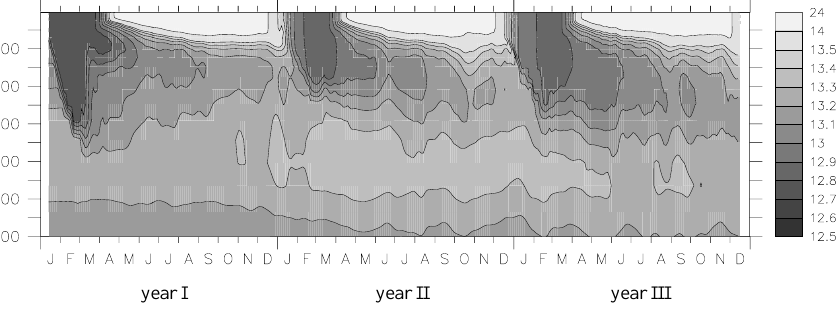
Fig. 14. Temporal evolution of the vertical profile of temperature (shaded, isotherms in ◦ C) in the central Gulf of Lions (5 ◦ E 41.5 ◦ N–42 ◦ N).